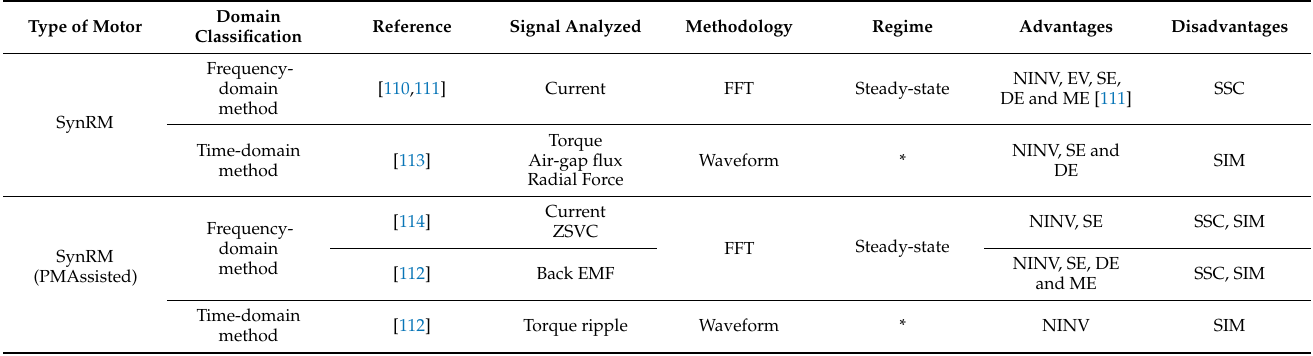
Table 4. Classification of detection methods for eccentricity faults in PMSMs and